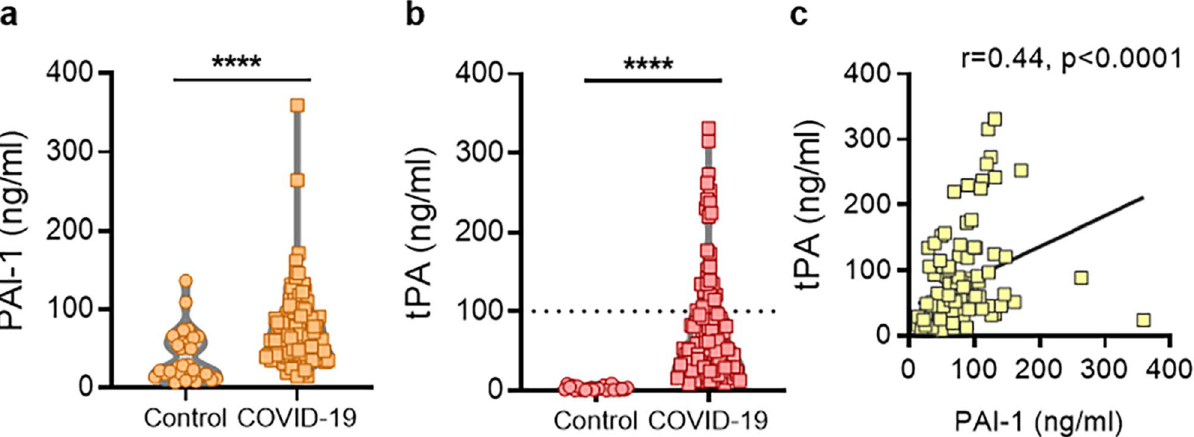
Figure 1. High levels of tPA and PAI-1 among patients with COVID-19. ( a , b ) PAI-1 and tPA were measured in individuals with COVID-19, or healthy controls. Levels of PAI-1 and tPA were compared by Mann–Whitney test as samples were not normally distributed when assessed by Shapiro–Wilk test; **** p < 0.0001 as compared with the control group. Dotted line indicates high tPA cut-off. c, The relationship between tPA and PAI-1 was assessed by Spearman’s correlation test. Statistics were calculated and the figure was produced in GraphPad Prism https ://www.graph pad.com/scien tific -softw are/prism /, using version Levels of PAI‑1 and tPA associate with severe disease and worse outcomes. Compared with patients breathing room air, patients requiring oxygen had significantly higher levels of PAI-1 ( p = 0.02) (Fig. 3a), but not tPA or D-dimer (Fig. 3b,c). Beyond mode of respiratory support, oxygenation efficiency can also be measured by comparing pulse oximetry (SpO 2 ) to the fraction of inspired oxygen (FiO 2 ). We tested the correla- tion between PAI-1, D-dimer and SpO 2 /FiO 2 ratio and found a strong negative association (r = -0.35, p = 0.0002 for PAI-1; r = -0.37, p = 0.009 for D-dimer;) (Fig. 3d,f). A negative association was also appreciated between oxy- genation efficiency and tPA (r = -0.19, p = 0.04), albeit less robust than for PAI-1 and D-dimer (Fig. 3e). Among the 118 patients, 24 died, 92 were discharged, and two remained hospitalized at the time of this analysis. Sig- nificantly higher levels of both PAI-1 ( p = 0.04) and tPA ( p = 0.0003) were observed among patients who died as compared with those who were discharged, with this difference being especially robust for tPA (Fig. 3g,h). Surprisingly, we did not see a significant difference in D-dimer levels between those two groups (Fig. 3i). In sum- mary, high levels of tPA and PAI-1 were associated with worse respiratory status and poor clinical outcomes; in particular, high levels of tPA were strongly associated with death. High tPA COVID‑19 samples have enhanced spontaneous fibrinolysis. Finally, we asked whether COVID-19 plasma with the highest tPA levels might demonstrate enhanced spontaneous fibrinolysis as com- pared with low-tPA COVID-19 plasma or control plasma. A spontaneous fibrinolysis assay was performed on 10 COVID-19 plasma samples with high tPA (> 100 ng/mL), 10 COVID-19 samples with low tPA (< 20 ng/mL), and 10 healthy control plasma samples (mean value 2.4 ng/mL). Notably, the high-tPA COVID-19 samples significantly enhanced spontaneous fibrinolysis as compared with low-tPA and healthy control plasma samples (Fig. 4a,b). Consistent with this observation, we found that tPA levels were on average 2.2-fold higher than PAI-1 in the high tPA patients (Supplementary Fig. 1A,B). This was in contrast to the ratio in control plasma samples (where PAI-1 levels averaged more than tenfold greater than tPA) or in COVID-19 patients with tPA less than 20 ng/mL (where PAI-1 levels were > twofold greater than tPA). No significant difference in age or oxygenation efficiency were observed in a subset of ten high tPA and ten low tPA patients (Supplementary Fig. 2). Detailed